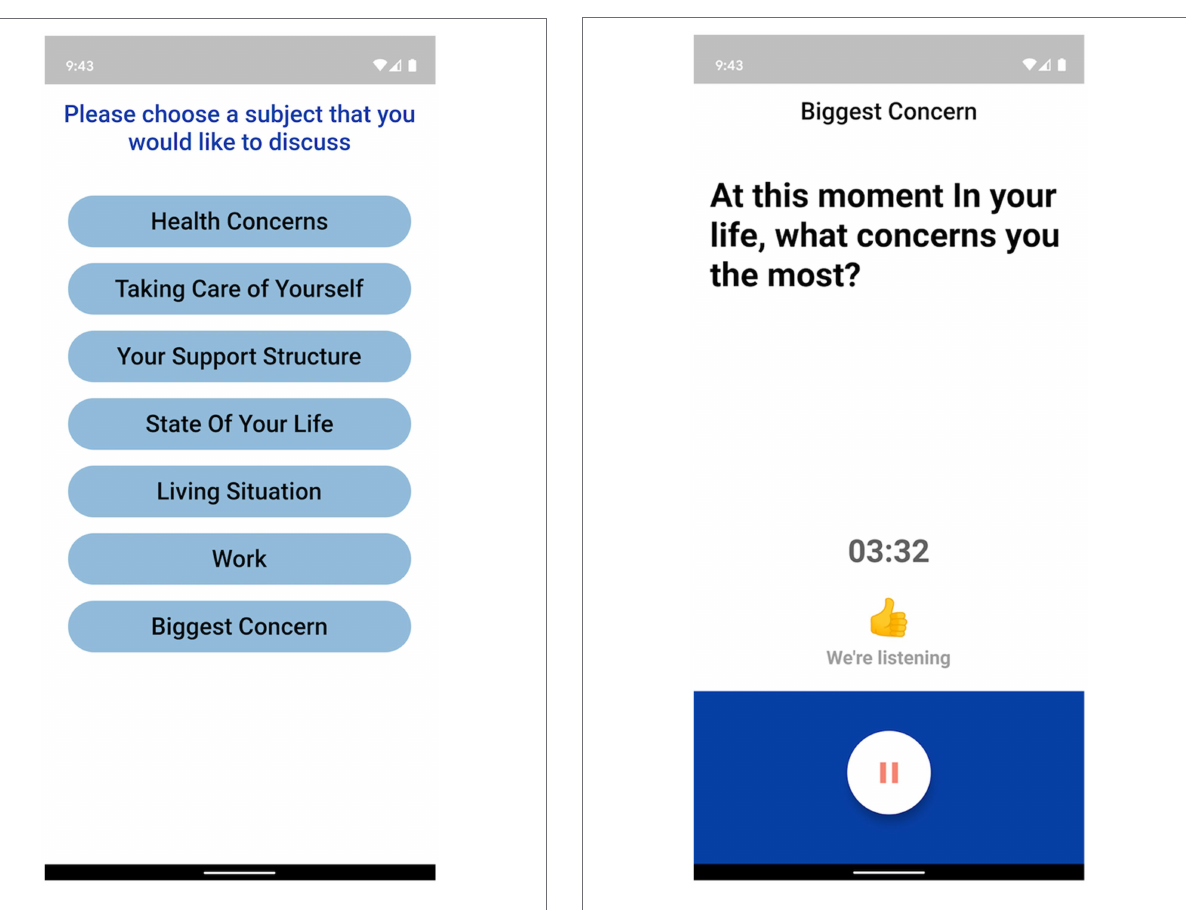
FIGURE 1 | Topic choice for Ellipsis Health App participants. FIGURE 2 | Question prompt for Ellipsis Health App